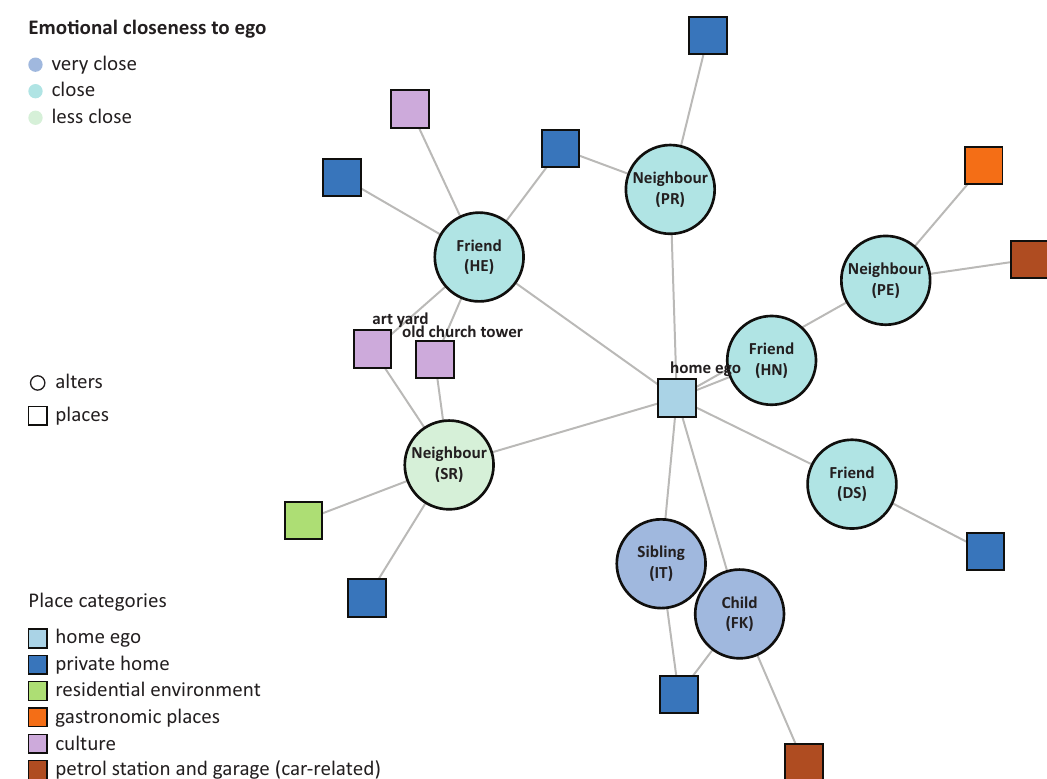
Figure 3. Two‐mode network of Mrs Schmidt. Notes: Twenty‐three isolated places are not shown; places are depicted as squares and annotated when they are mentioned in the analysis; alters are depicted by circles and their emotional close‐ ness to ego is indicated by node colour; ties between alters and places indicate that ego and alter meet at these places or they visit them together according to ego’s account; layout based on the Fruchterman‐Reingold algorithm. Own